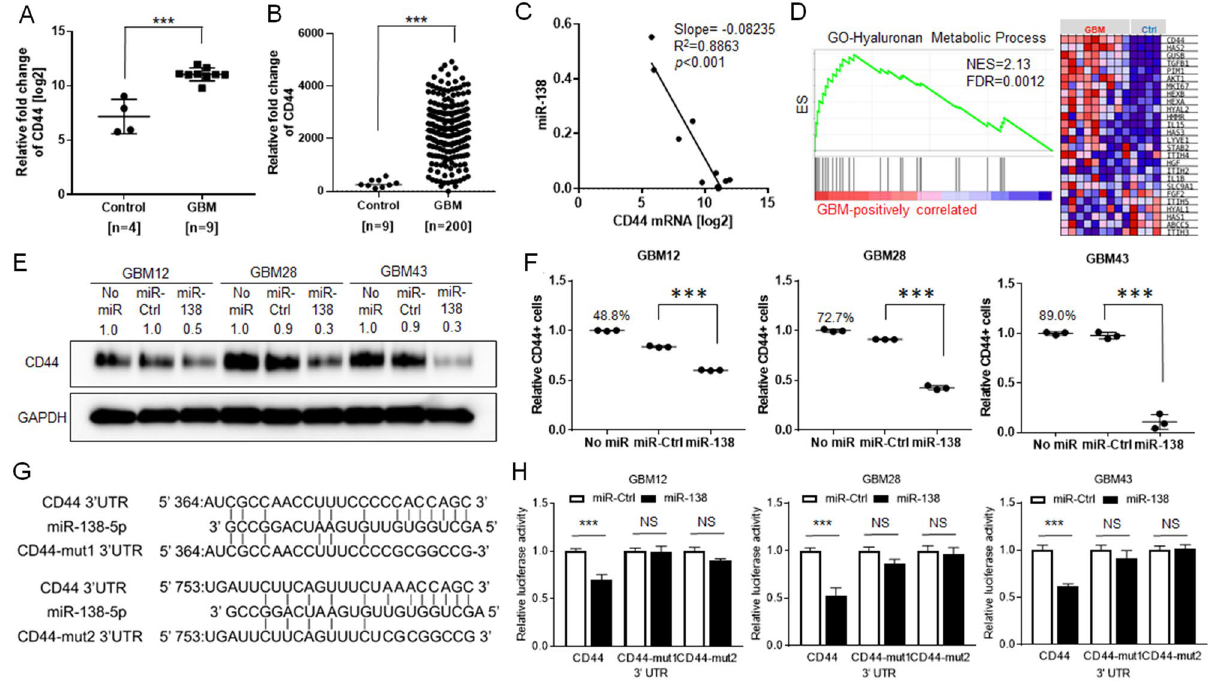
Figure 3. miR-138 negatively regulates the expression of CD44 through direct targeting its 3 ′ UTR. ( A ) Overexpression of CD44 in human GBM patient samples (11.06 ± 0.1995, n = 9) compared to control samples (7.168 ± 0.7913, n = 4) as measured by SyBr-Green real-time quantitative PCR (qRT-PCR) (*** p < 0.001). ( B ) TCGA database showed the overexpression of CD44 in GBM (2329 ± 76.09, n = 200) compared to control samples (299.9 ± 50.01, n = 9) (*** p < 0.001). ( C ) Paired expression correlation between miR-138 and CD44 in human GBM patient samples (Slope = − 0.08235, R 2 = 0.8863, p < 0.001, n = 13 (9 GBM and 4 controls)). The expression levels of miR-138 and CD44 were measured by TaqMan miRNA expression assay or SyBr-Green real- time quantitative PCR (qRT-PCR), respectively. ( D ) Enrichment plot by Gene Set Enrichment Analysis (GSEA) showed the enriched genes including CD44 involving in hyaluronan metabolic pathway. ( E ) Western blotting on GBM cells with transient overexpression of miR-138. The protein expression levels of CD44 were significantly lower than miR-Ctrl treated GBM cells. ( F ) Detection of CD44 positive cells by flow cytometry on GBM cells after miR-138 overexpression in comparison to control groups with no miR or miR-Ctrl overexpression. Transiently transfected GBM cells with miR-138 mimics were stained with FITC-labeled anti-CD44 antibodies and analyzed. FICT-negative cell population was gated by analyzing GBM cells transfected with siRNAs against CD44 (Supplementary material Fig. S5). ( G ) Schematic diagram of 3 ′ UTR sequences of CD44 containing two predicted miR-138 binding sites and the reporter constructs showing the mutated sequences in the seed regions (CD44-mut1 and CD44-mut2). ( H ) Luciferase reporter assays to test directing binding of miR-138 to the CD44 3 ′ UTR regions in GBM cells. GBM cells were transfected with luciferase reporter gene expressing DNAs containing CD44 3 ′ UTR, CD44-mut1 or CD44-mut2 sequences respectively. Next day, the cells were further transfected with miR-138 or miR-Ctrl for 48 h. Passively lysed cell lysates were assayed for luciferase activity by Dual Luciferase Assay kit. The relative luciferase activity values were normalized to Renilla luciferase activity as internal control. All error bars indicates standard deviations (n = 3), and the p -values were determined by two- tailed student t -test. *** p <